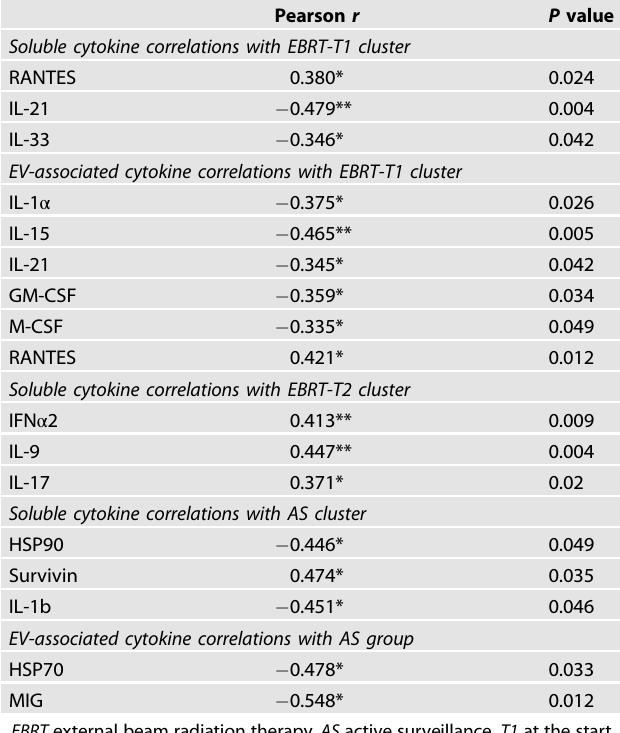
Table 2. Bivariate correlations between EBRT-T1, EBRT-T2, and AS symptom clusters and soluble and EV-associated immune